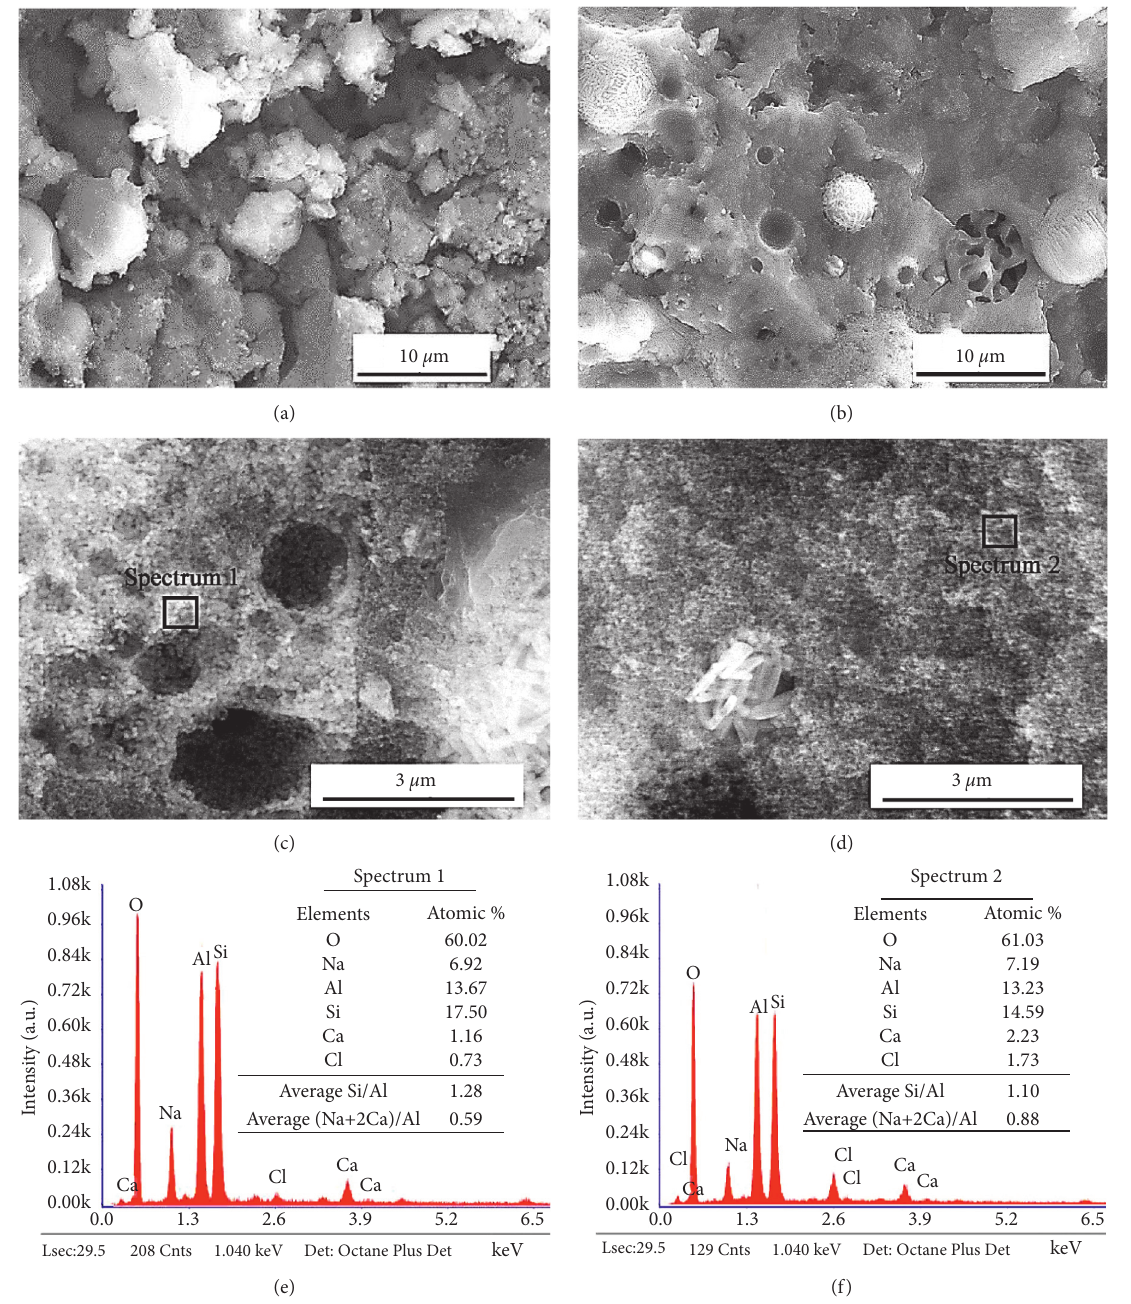
Figure 4: The SEM images of (a) PNT1, (b) PST1, (c) PST2, (d) PST3, and the EDS spectra of (e) spectrum 1 and (f) spectrum 2 in gel products of PST2 and PST3 at